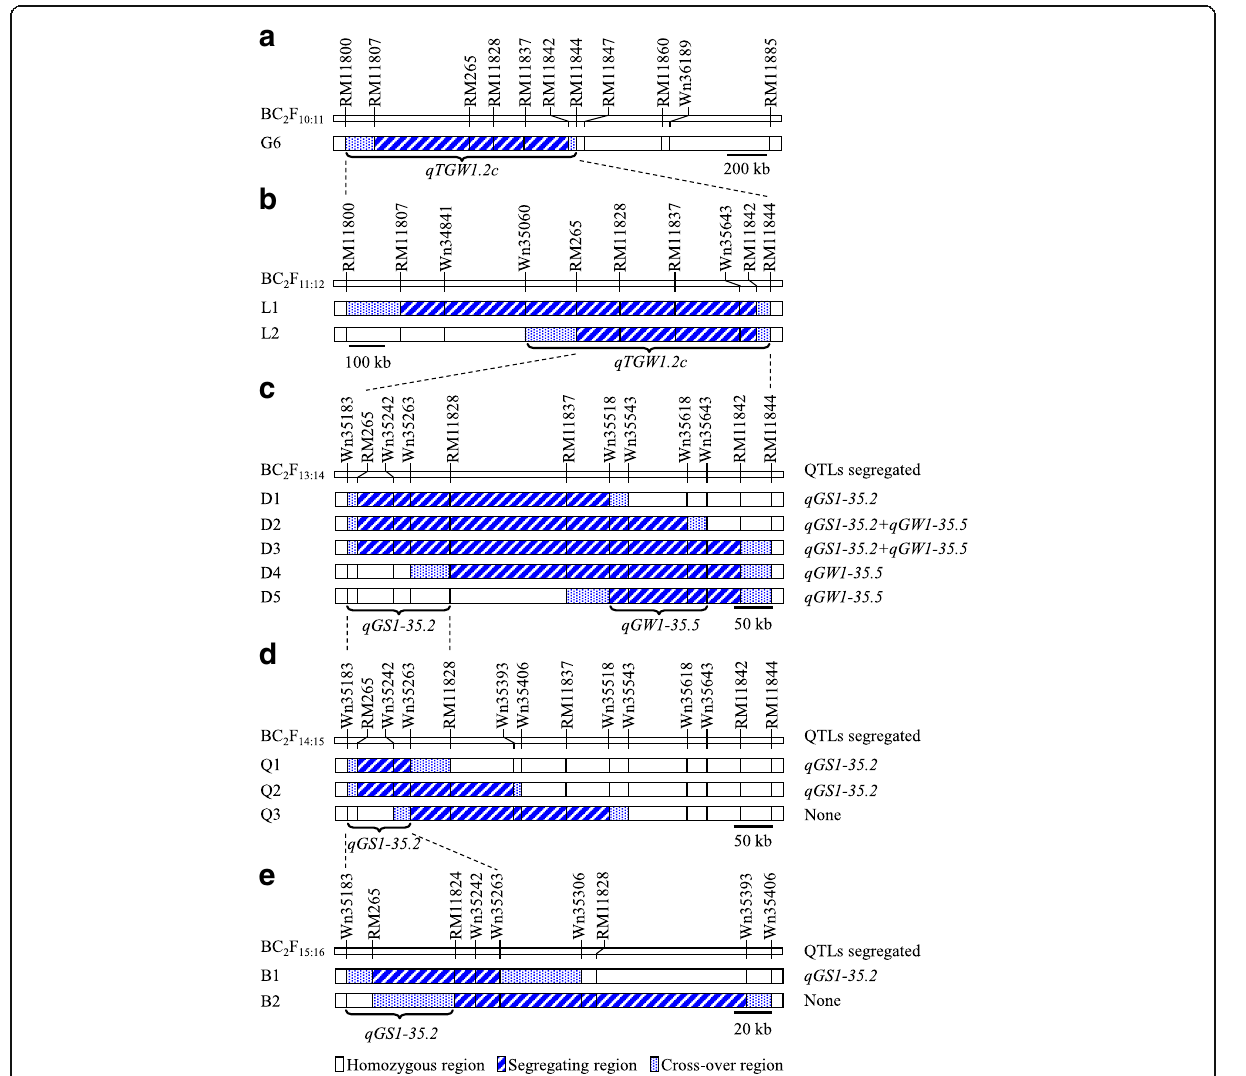
Fig. 2 Genotypic compositions of the near isogenic lines (NILs) in target regions. a Composition of NIL set G6 used by Wang et al. (2015c), updated in this study with more polymorphic markers. b Two sets of NILs in BC 2 F 11:12 . c Five sets of NILs in BC 2 F 13:14 . d Three sets of NILs in BC 2 F 14:15 . e Two sets of NILs in BC 2 F